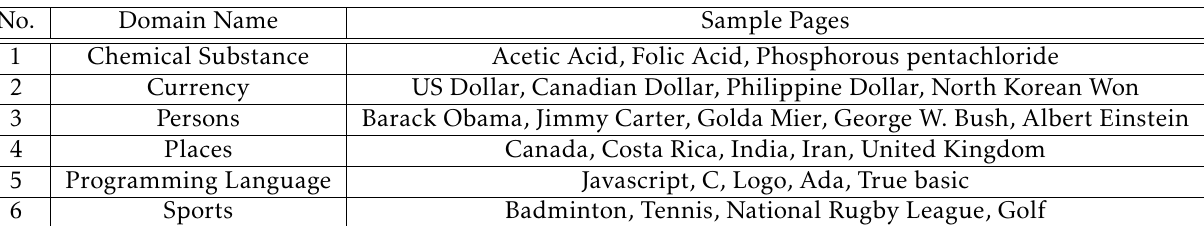
Table 1. Wikipedia Domains and Sample Pages